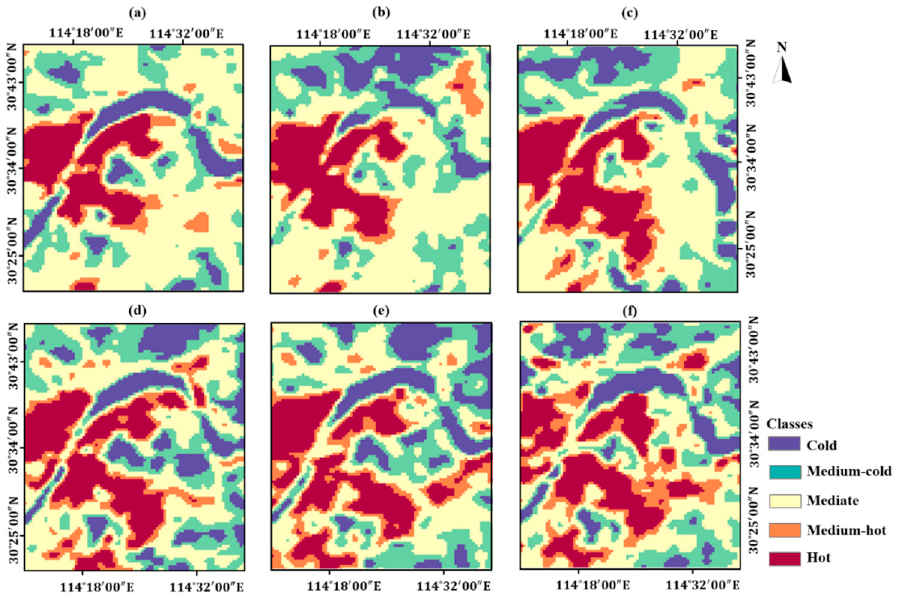
Figure 7. The five categories of thermal landscapes in Wuhan from 2002 to 2017. ( a ) 2002; ( b ) 2005; ( c ) 2008; ( d ) 2011; ( e ) 2014; ( f ) 2017.